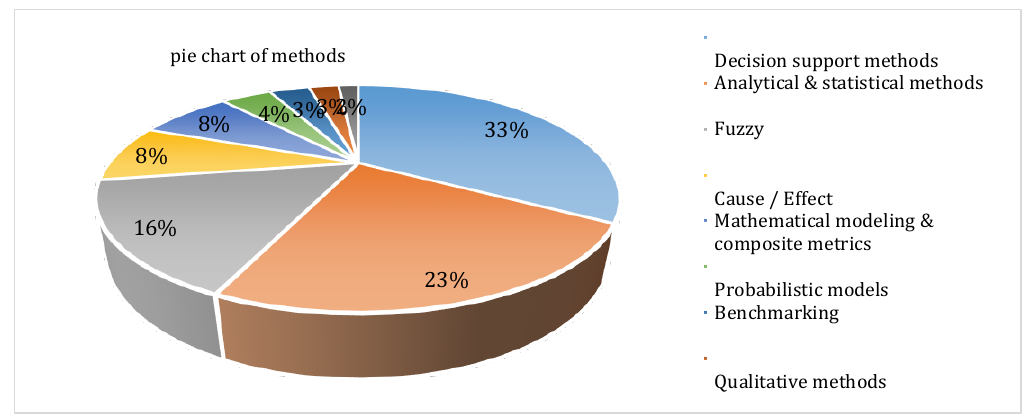
Figure 4: Pie chart detailing the methods’ distribution